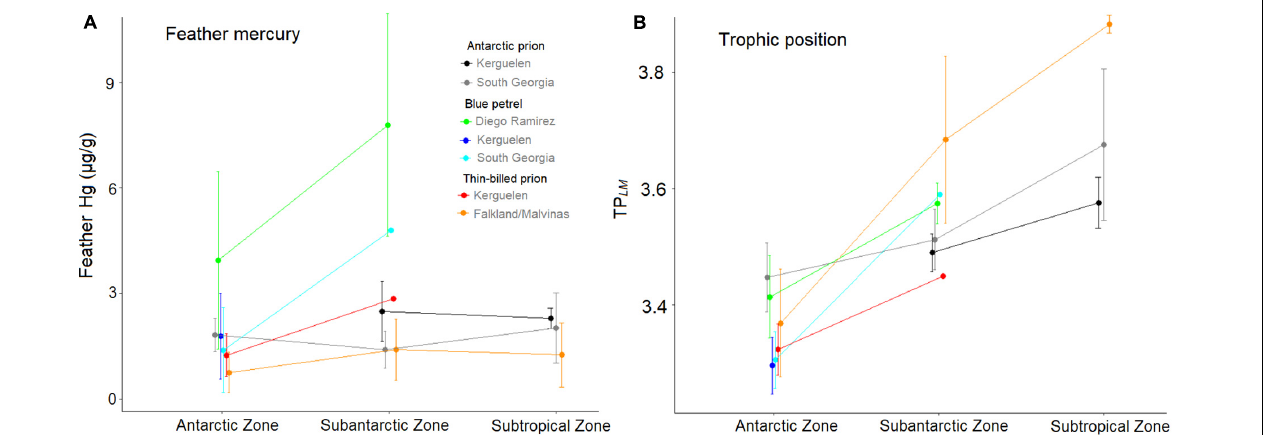
FIGURE 3 | Mercury and trophic position in feathers of Blue Petrels, Thin-billed Prions, and Antarctic Prions (BP, TBP, and AP, respectively). The mercury (A) and trophic position (B) values are shown for the seven populations, separately for habitat zones. Habitat was derived from δ 13 C following Cherel et al. (2018), as Subtropical Zone (STZ): δ 13 C >